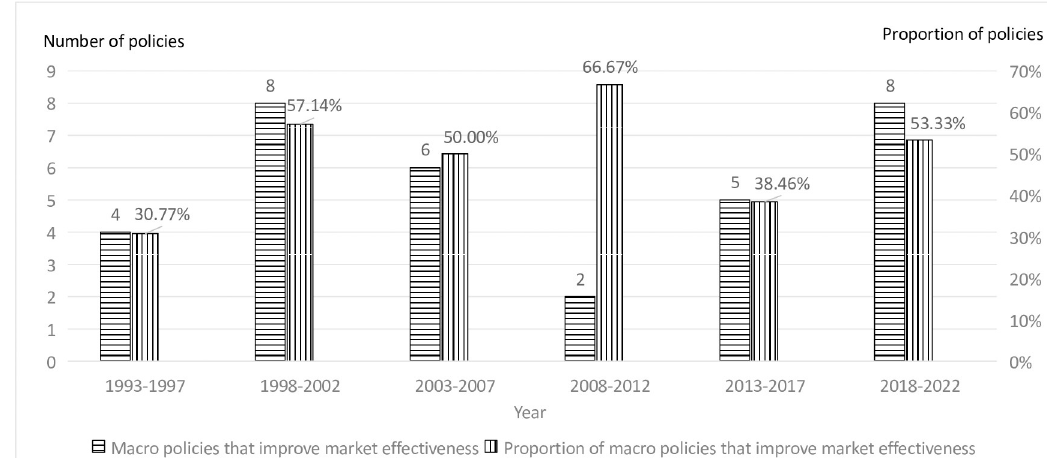
Fig 4. Time evolution chart of the macro policy effect in China’s stock